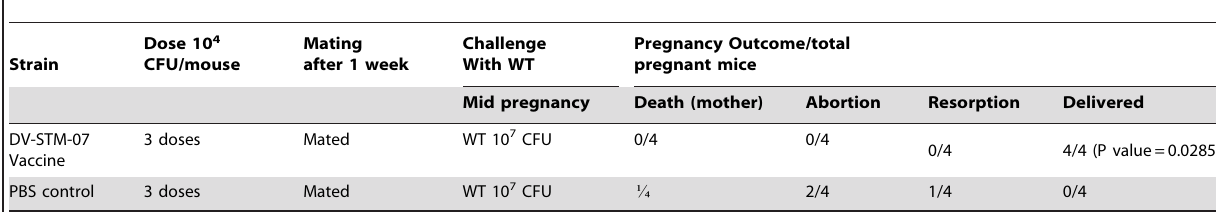
Table 2. Pregnancy outcome after challenging the pre-pregnancy vaccinated mice with WT.